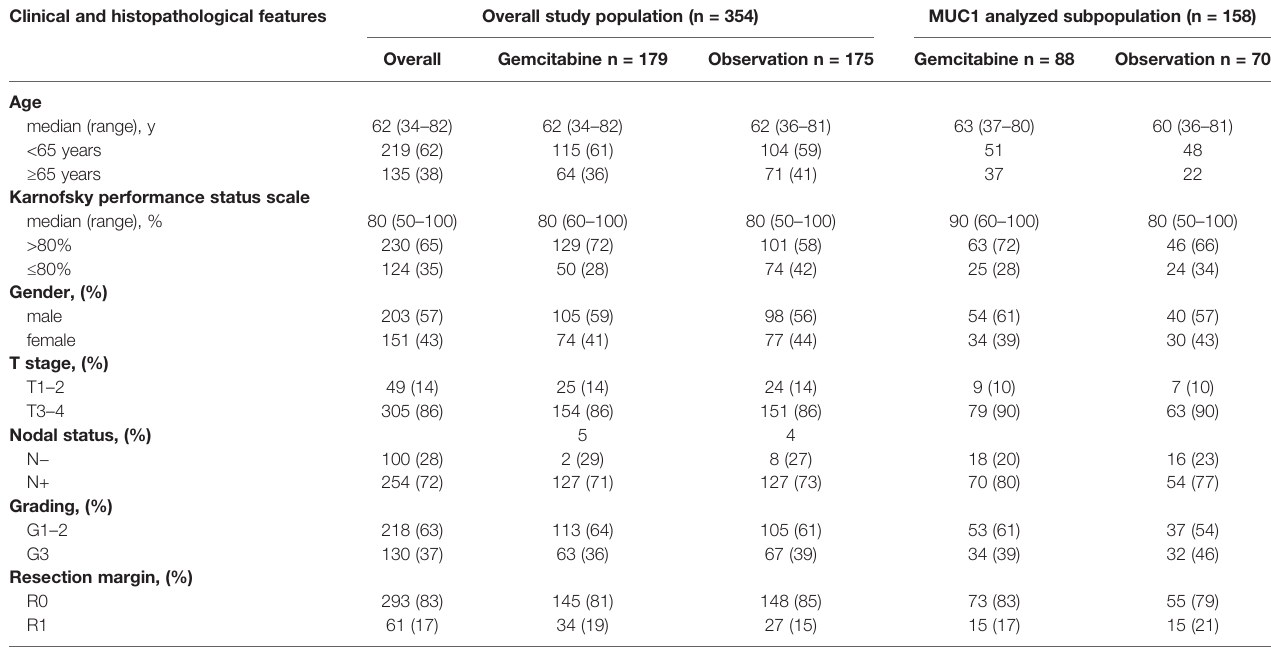
TABLE 2 | Association of MUC1 expression level and selected patient